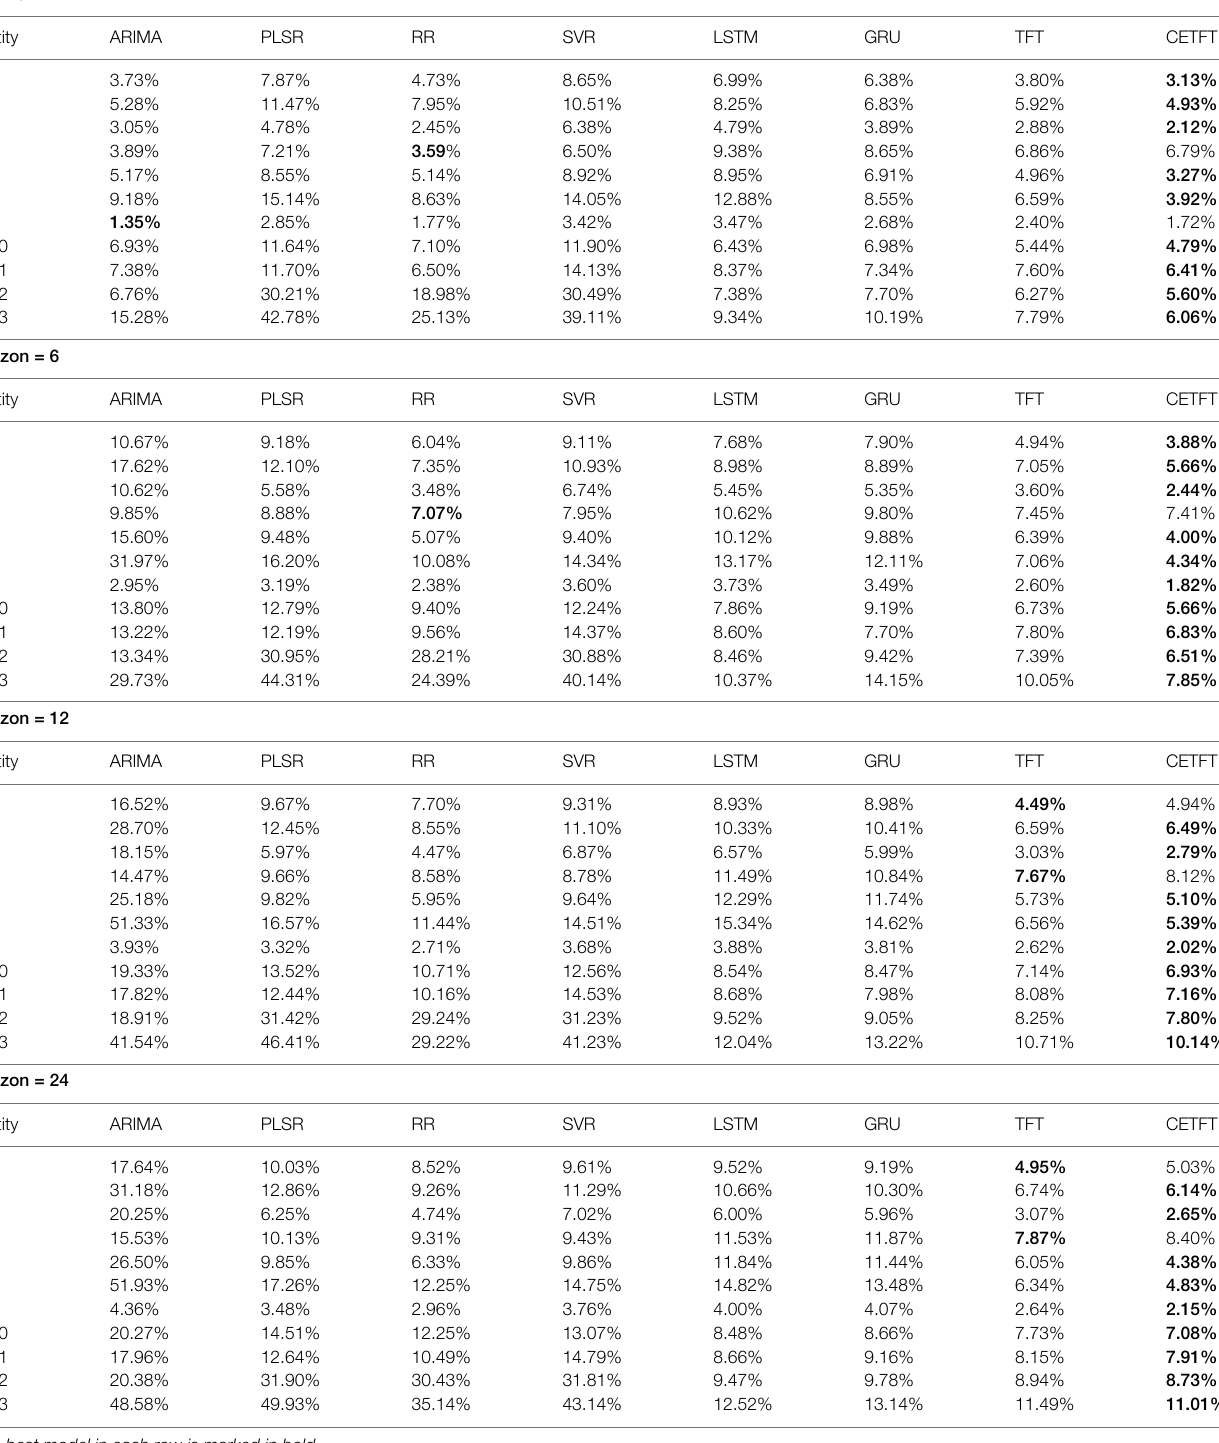
TABLE 3 | SMAPE on the UTD